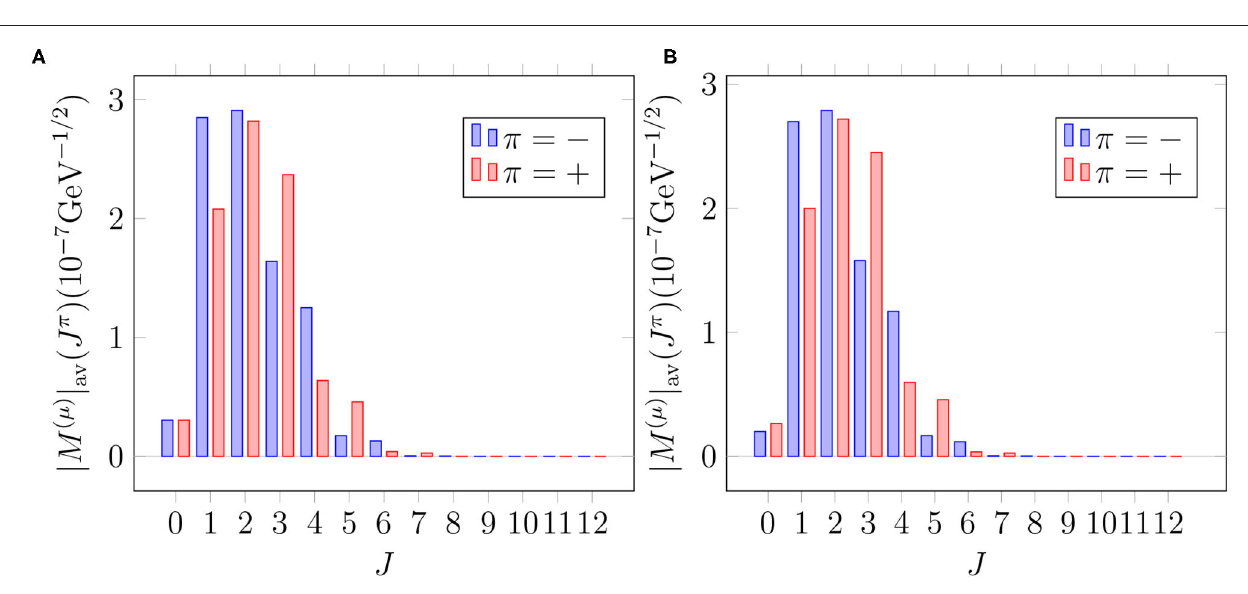
FIGURE 4 | Multipole decomposition of the total OMC matrix element in different single-particle bases. Here we have used the bound muon wave function solved from the Dirac equation. The decompositions correspond to the parameter value g ( T = 0) pp = 0.7. Note that the unit and scale of the matrix element comes from our definition of the average OMC matrix element (20). For more information, see the text and [26]. (A) Basis: “Adj.”. (B) Basis: